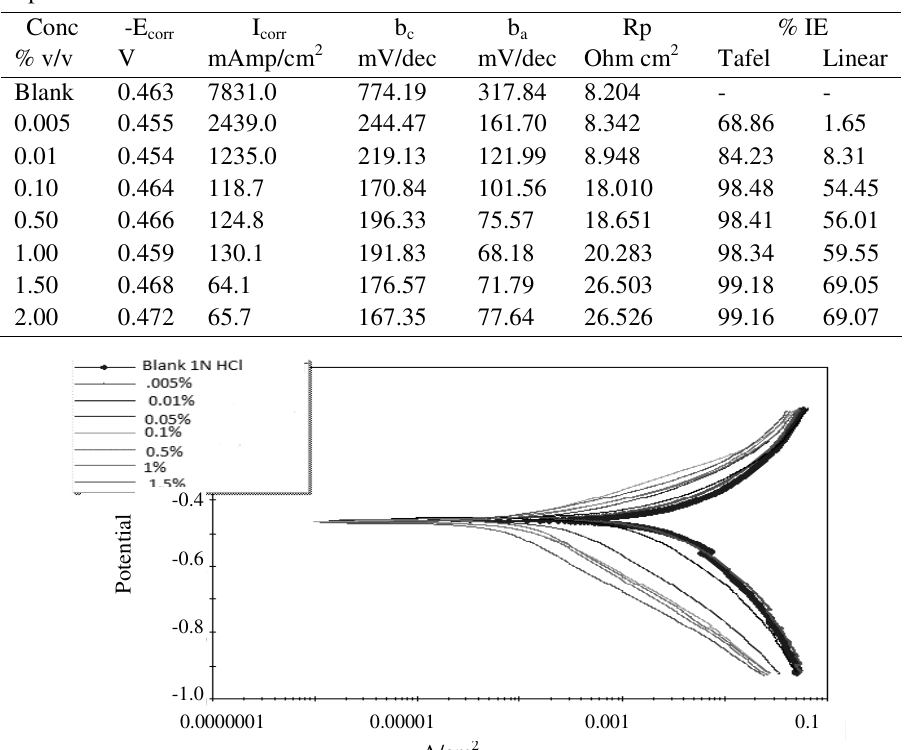
Table 3. Potentiodynamic polarization parameters for mild steel in 1 N HCl in the absence and presence of MNP extract